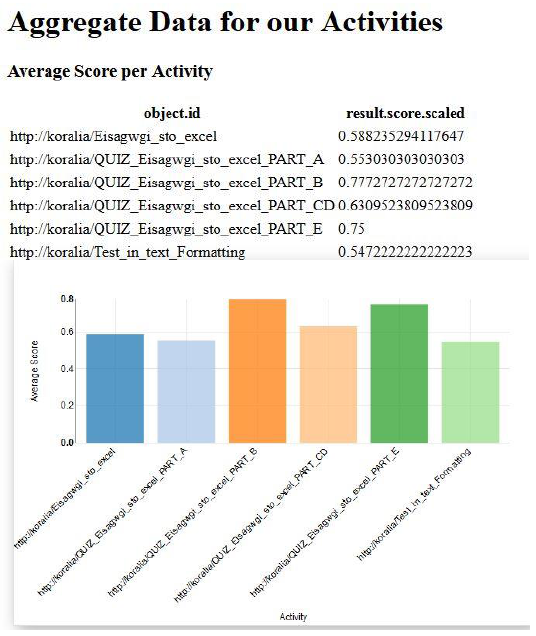
Figure 21. The average score for every activity